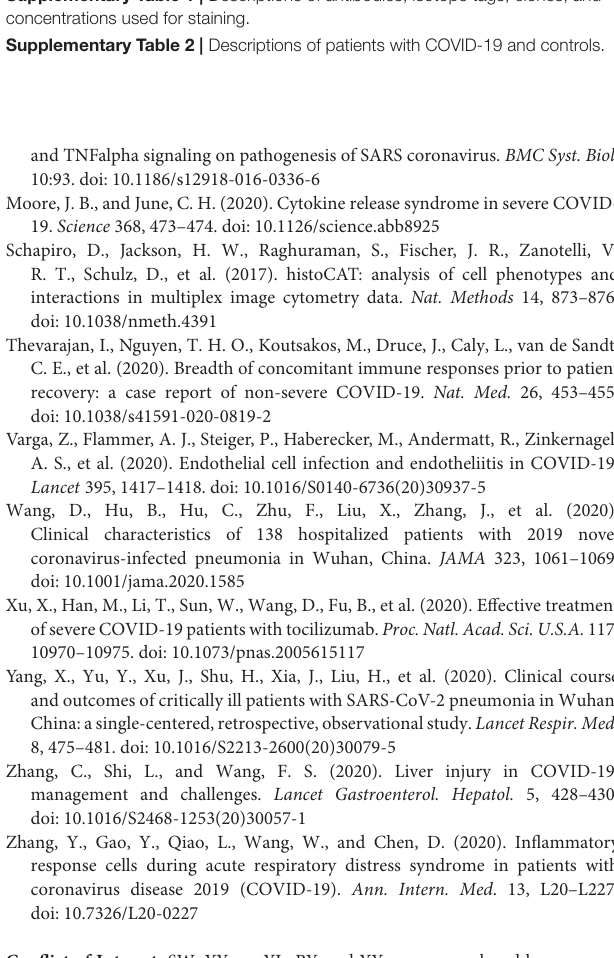
Supplementary Figure 3 | Immune cell responses to severe acute respiratory syndrome coronavirus 2 (SARS-CoV-2) in the spleen of patients with coronavirus disease-2019 (COVID-19). Representative imaging mass cytometry (IMC) for each panel, with different colors to distinguish panels; iridium-DNA staining is shown in blue. (A) Monocytes (CD14 and CD68), CD11b + macrophages, CD11c + dendritic cells (DCs), natural killer T (NKT) cells (CD3 and CD56), and B cells (CD19) in the spleen of controls and patients with COVID-19. (B) Bar plot for the comparison of monocyte (CD14 and CD68), CD11b + macrophage, CD11c + DC, NKT cell (CD3 and CD56), and B cell (CD19) counts in the spleen of controls and patients with COVID-19. The significance of differences between groups is shown as horizontal brackets and was assessed using Fisher’s exact test. ∗∗∗ P < 0.01; ns, P > 0.01. Supplementary Table 1 | Descriptions of antibodies, isotope tags, clones, and concentrations used for staining. Supplementary Table 2 | Descriptions of patients with COVID-19 and